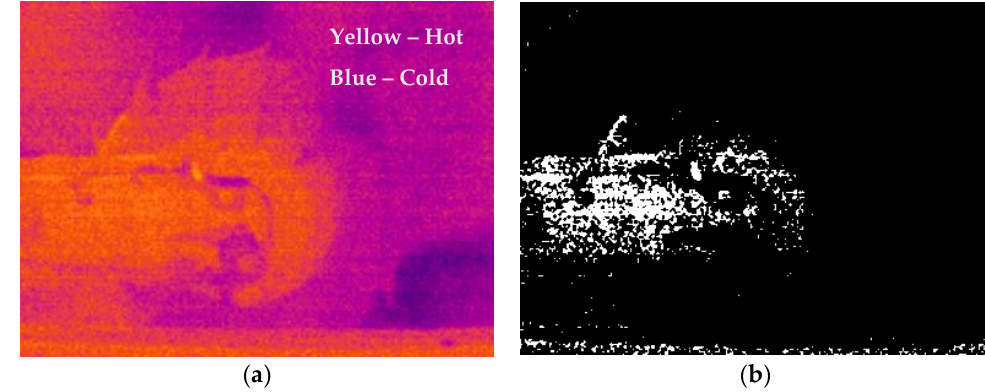
Figure 3. Binarization of an infrared thermal image containing the cutting unit: ( a ) original infrared thermal image; ( b ) binary image.